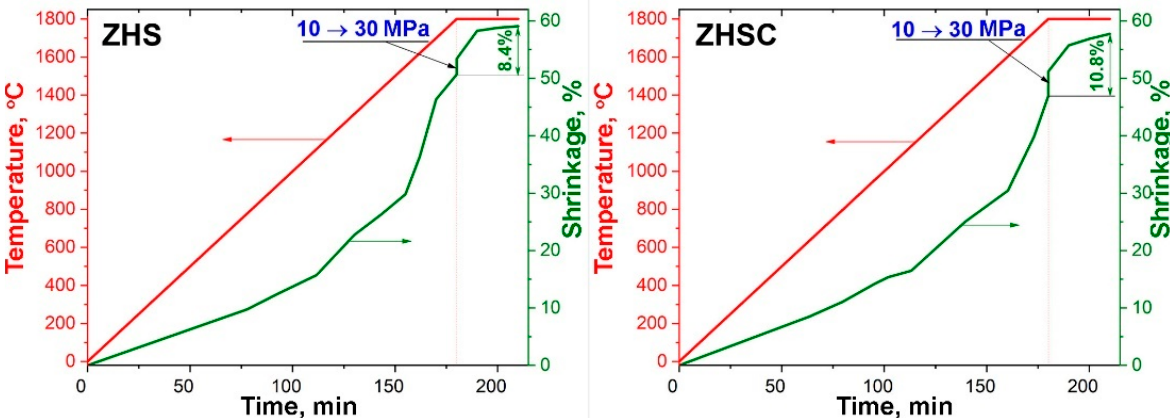
Figure 1. Shrinkage curves as a function of temperature and hot-pressing pressure for ZHS ( left ) and ZHSC ( right ) samples.